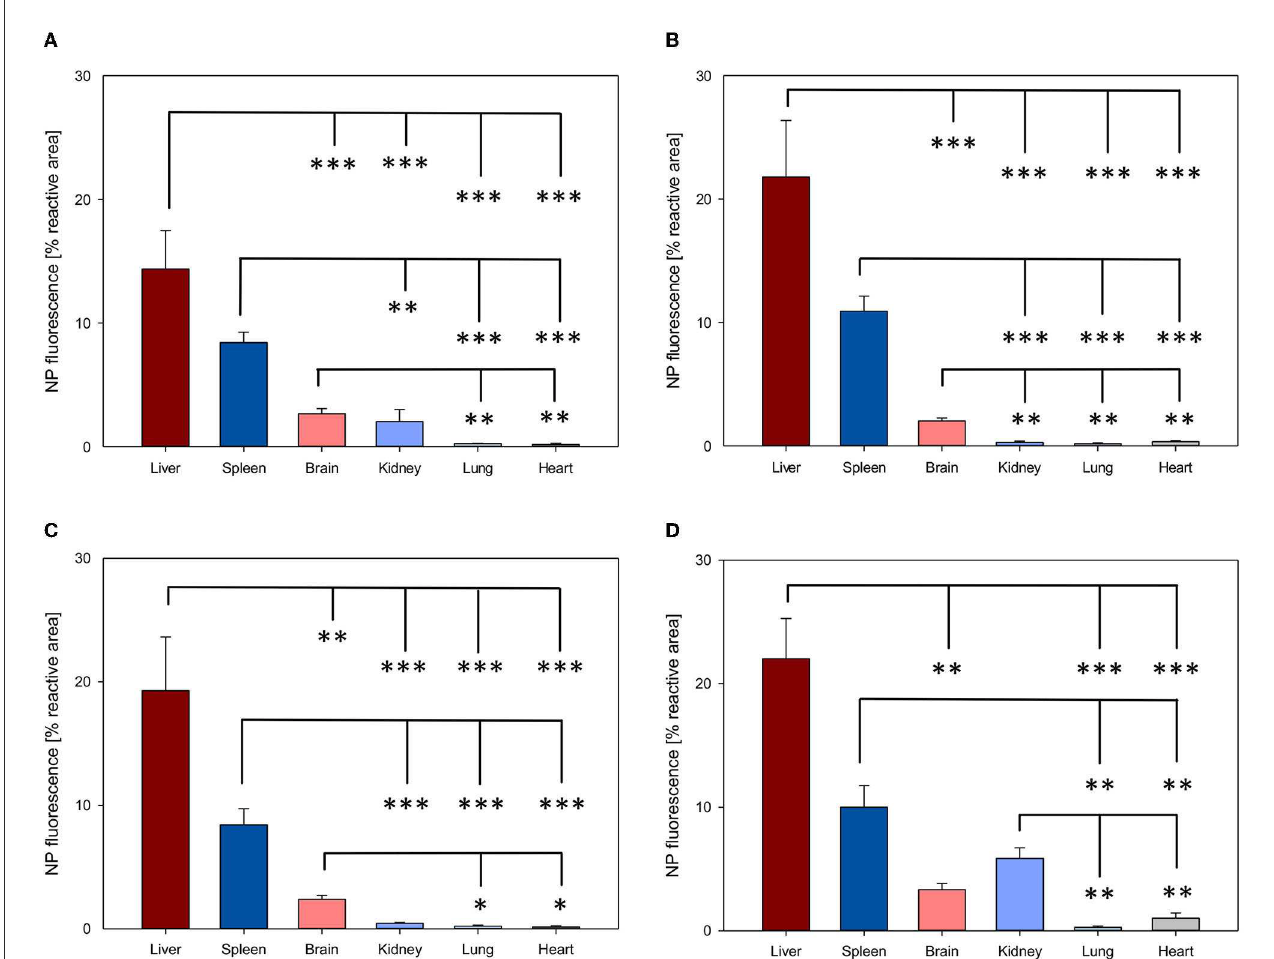
FIGURE3 Organ distribution of NP uptake 4h after intravenous injection. The accumulation of PFDL-Tw (A) , PFDL-SDS (B) , PLLA-Tw (C) , and PLLA-SDS (D) nanoparticles in all organs was assessed as the percentage of reactive fluorescent area in relation to the total area of the ROI at 40 × magnification. Overall, one-way ANOVAs showed higher NP uptake in the liver and spleen, followed by a moderate uptake in the brain and the kidney and minimal in the lung and the heart. Bars express means ± SEM. *** p < 0.001, ** p < 0.01, * p <